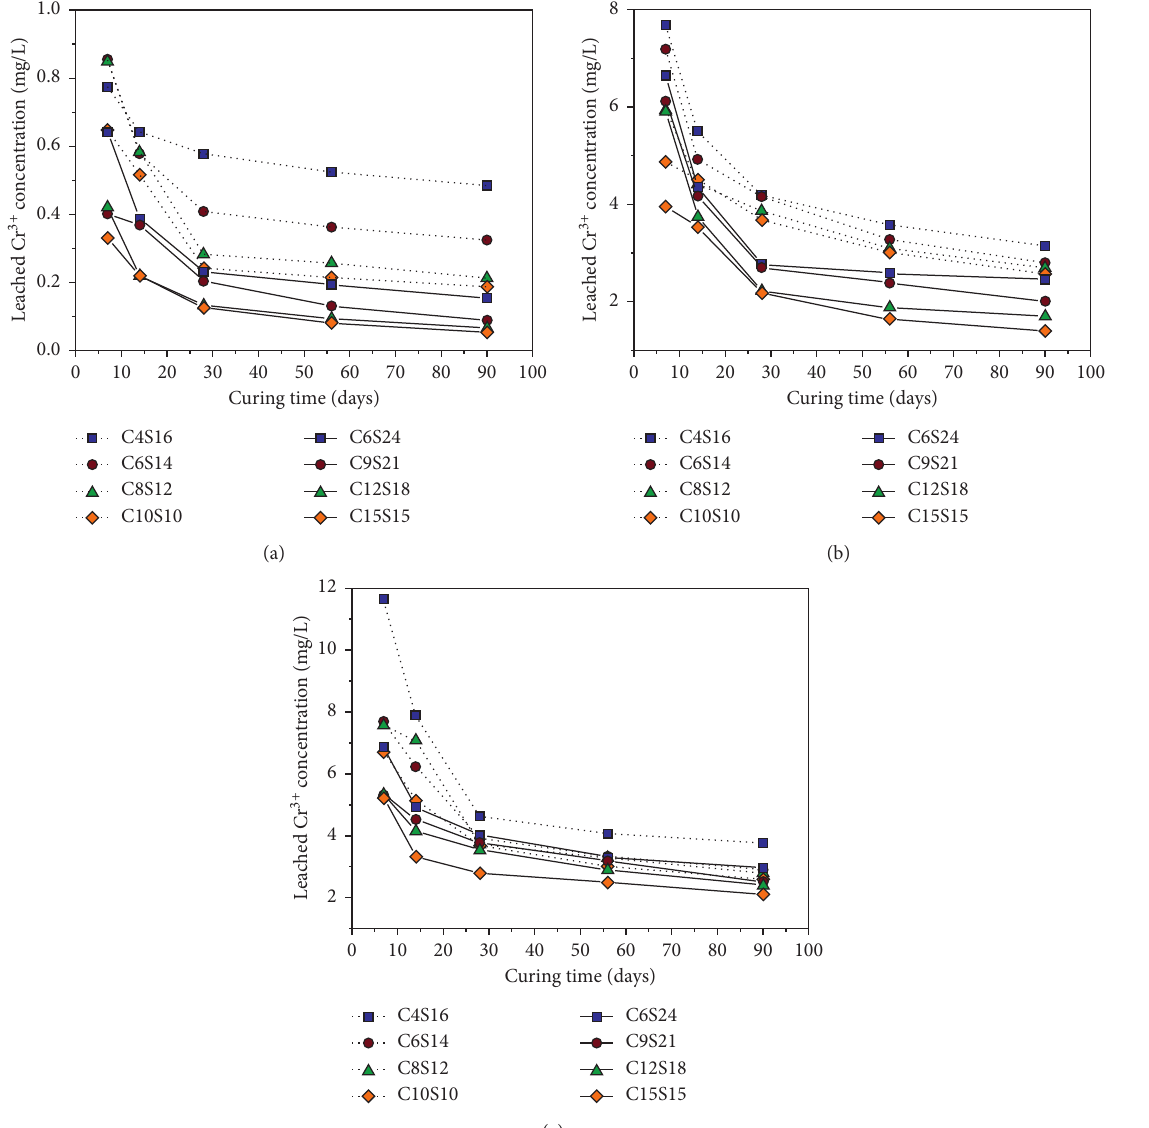
Figure 5: Evolutions of leached Cr 3+ concentration with curing time of stabilized Cr-contaminated soils: (a) Cr0.1, (b) Cr0.5, and (c)